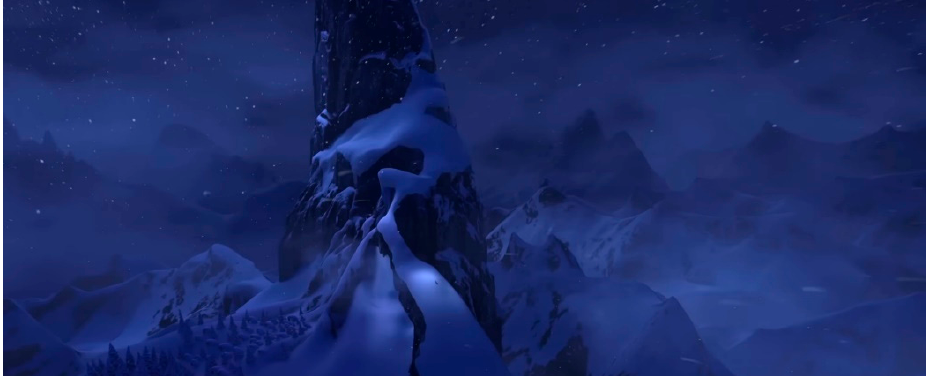
Figure 1. Elsa on the mountain (Walt Disney Animation Studios 2013a).